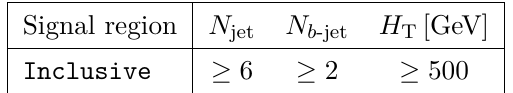
Table 3 . Summary of signal region criteria for ATLAS-CONF-2020-013, reproduced in full from section 3 of